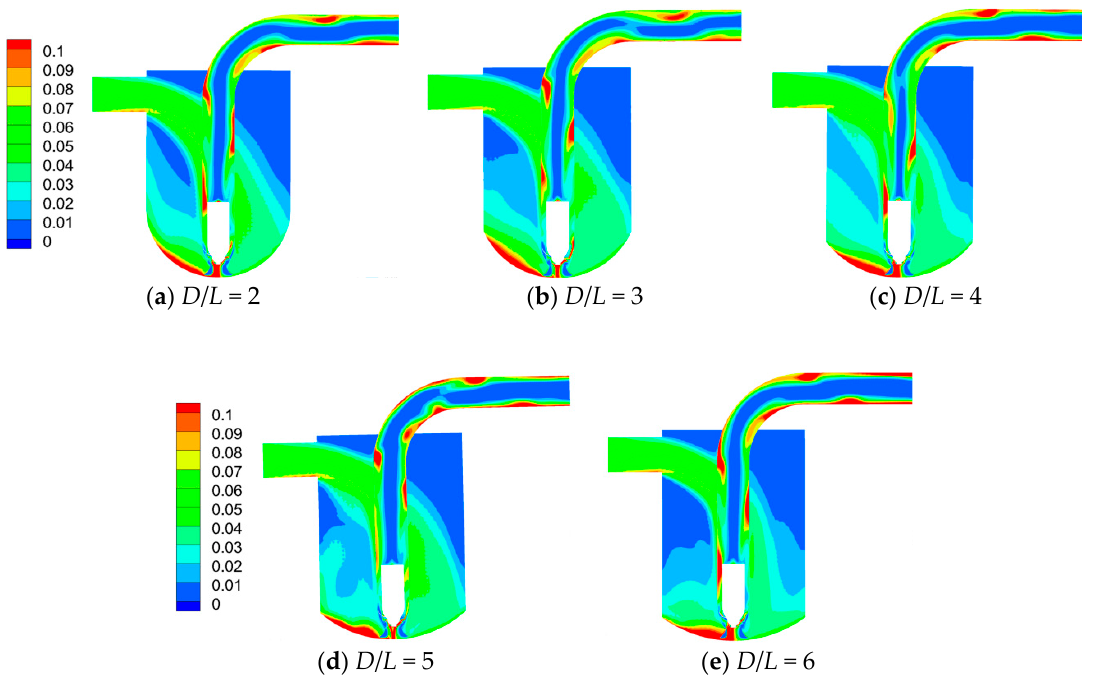
Figure 8. Cross-sectional distributions of the sand volume fraction (View 1). ( a ) D/L = 2; ( b ) D/L = 3; ( c ) D/L = 4; ( d ) D/L = 5; ( e ) D/L = 6.